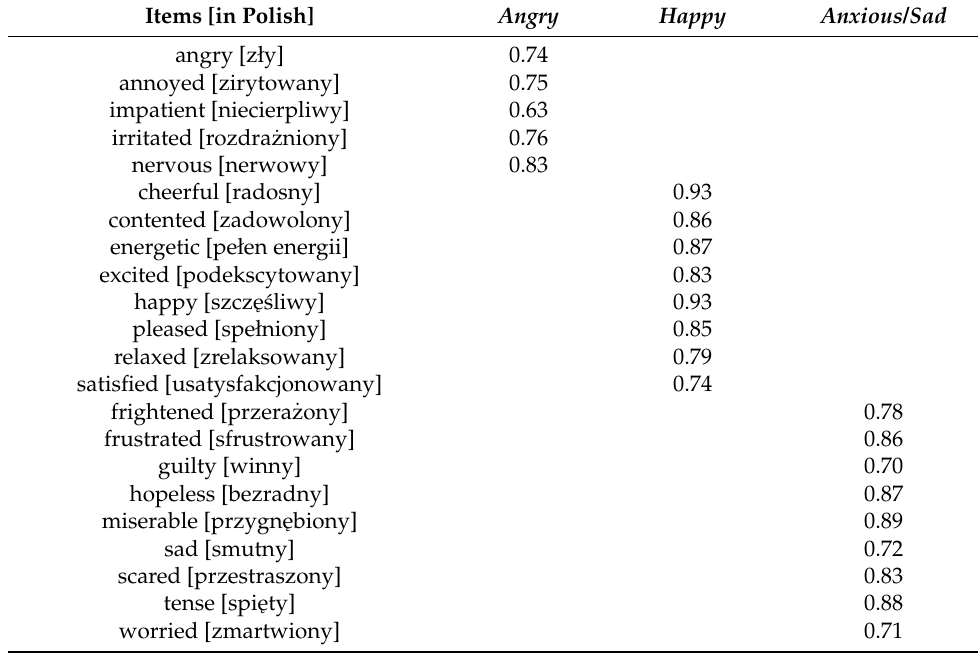
Table 3. CFA standardized factor loadings for each item of the PFI for parents (N =